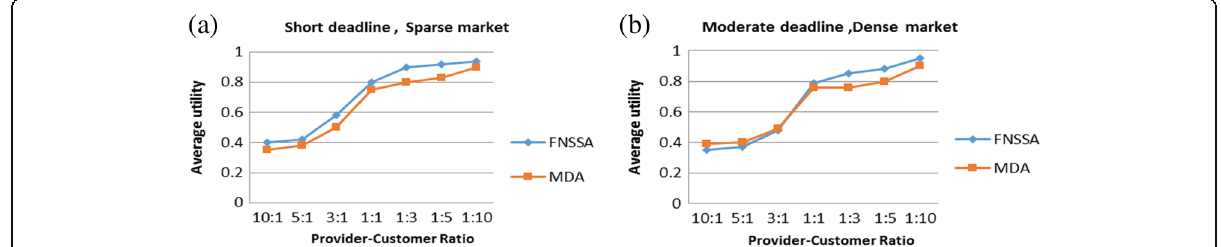
Fig. 9 Average utility of the CRPAs under a short deadline and sparse market, and b moderate deadline and dense market. In all figures different market types are considered